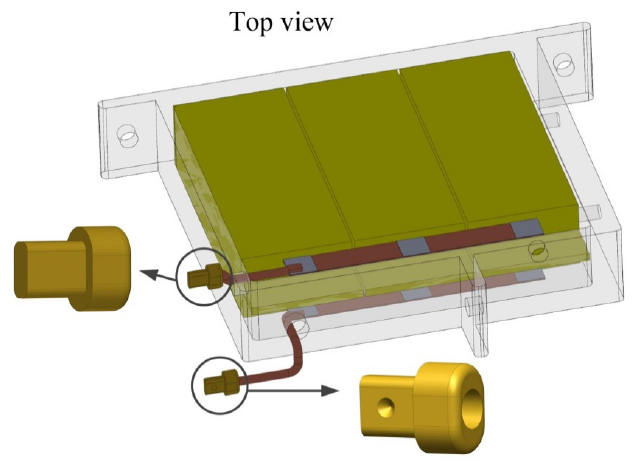
Figure 3. The assembly diagram of the PFN module.